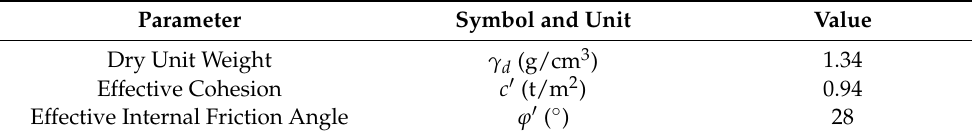
Table 1. Geotechnical properties of the soil at the Songnisan landslide monitoring